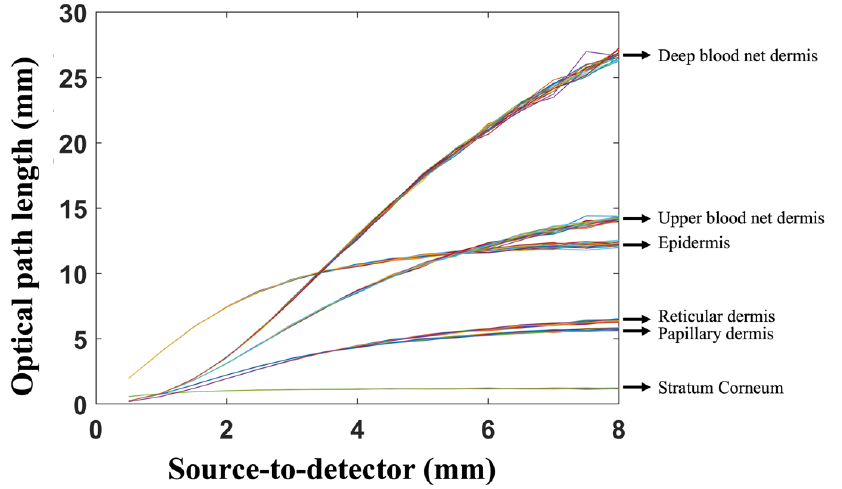
Figure 5. Optical pathlength for different layers at the wavelength of 550 nm. The MC simulations were run independently seeded for N = 20. The number of launched photons in the MC simulations was 100 × 10 6 .